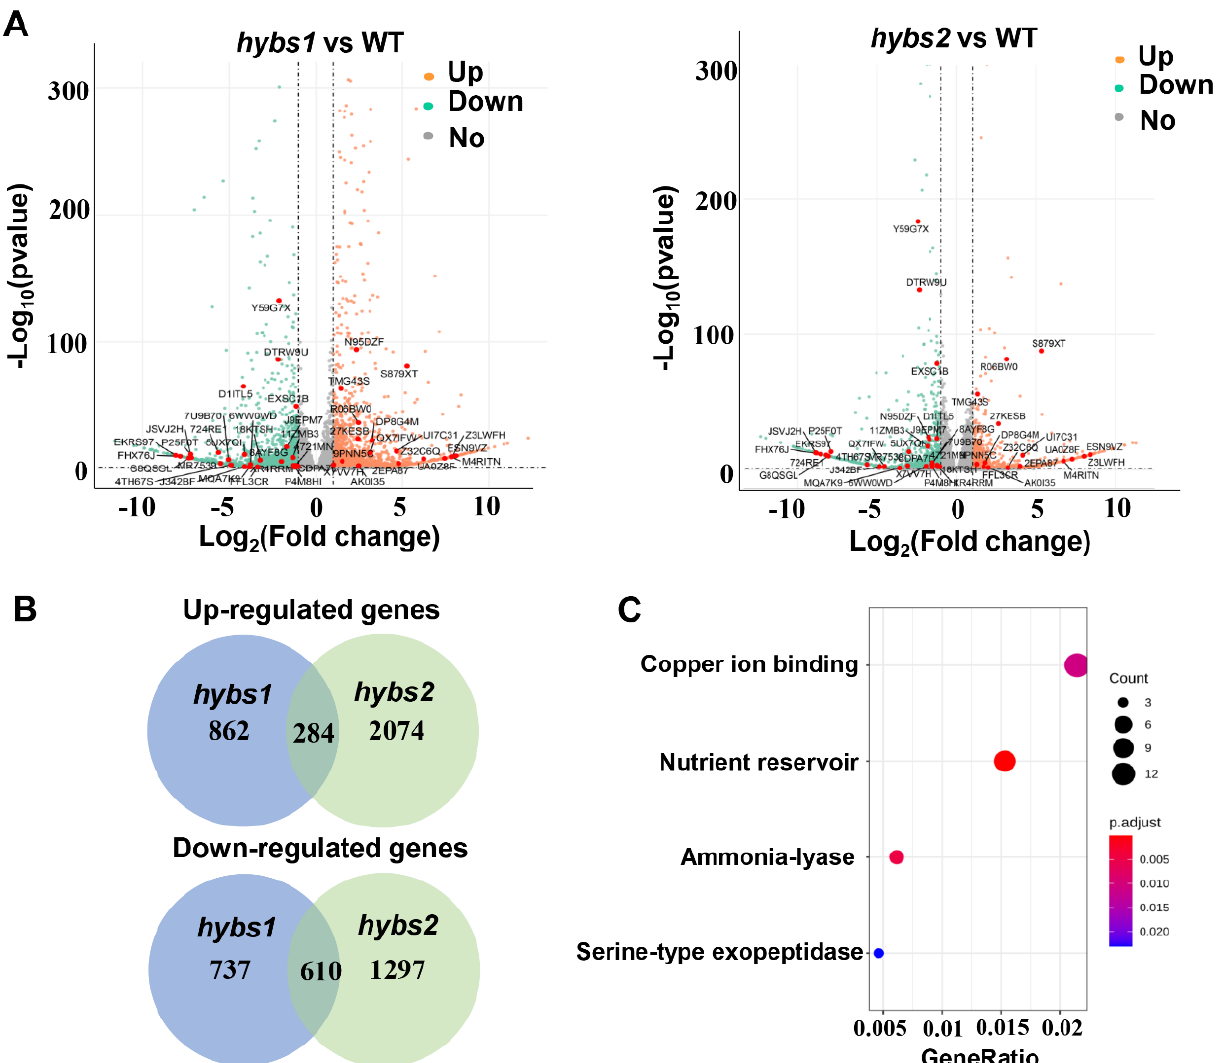
Figure 4. Differentially expressed genes in hybs mutants compared to WT. ( A ) The red dots indicate genes with significant up − regulation, and the cyan dots indicate genes with significant down − regulation. The 45 potential candidate genes were marked on the volcano plot. ( B ) The number of up − regulated and down − regulated genes shared by hybs1 and hybs2 . ( C ) The enriched biological processes for shared DEGs in the GO enrichment analysis.